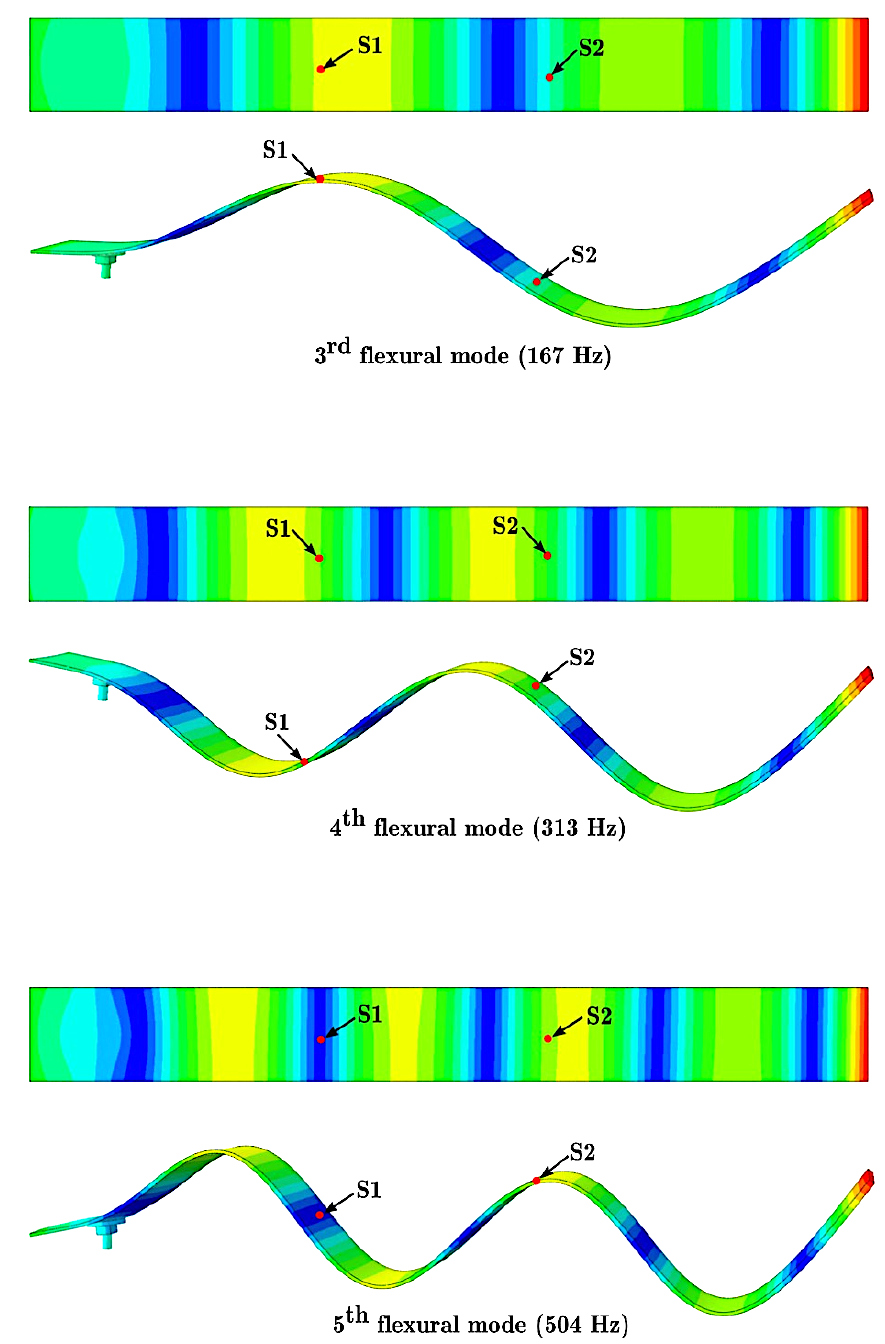
Figure 4. Modal shapes corresponding to the 3rd, 4th, and 5th flexural modes predicted by the FE simulations.